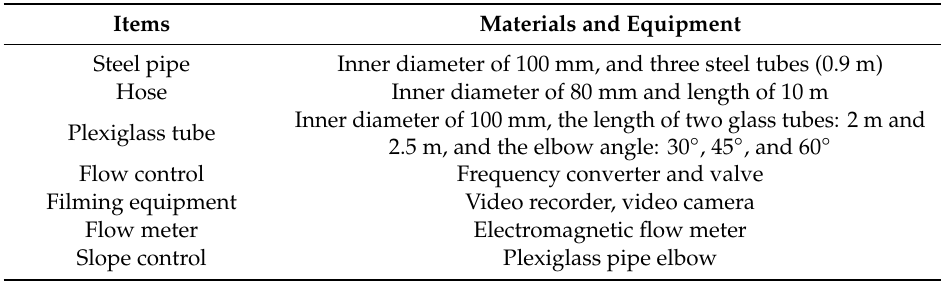
Figure 1. The frame diagram of model design. Table 1. Test materials and instruments.